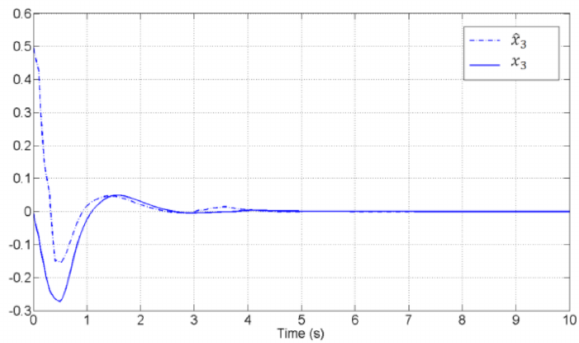
Figure 3. State trajectory of x 2 and state estimation trajectory ˆ x 2 .